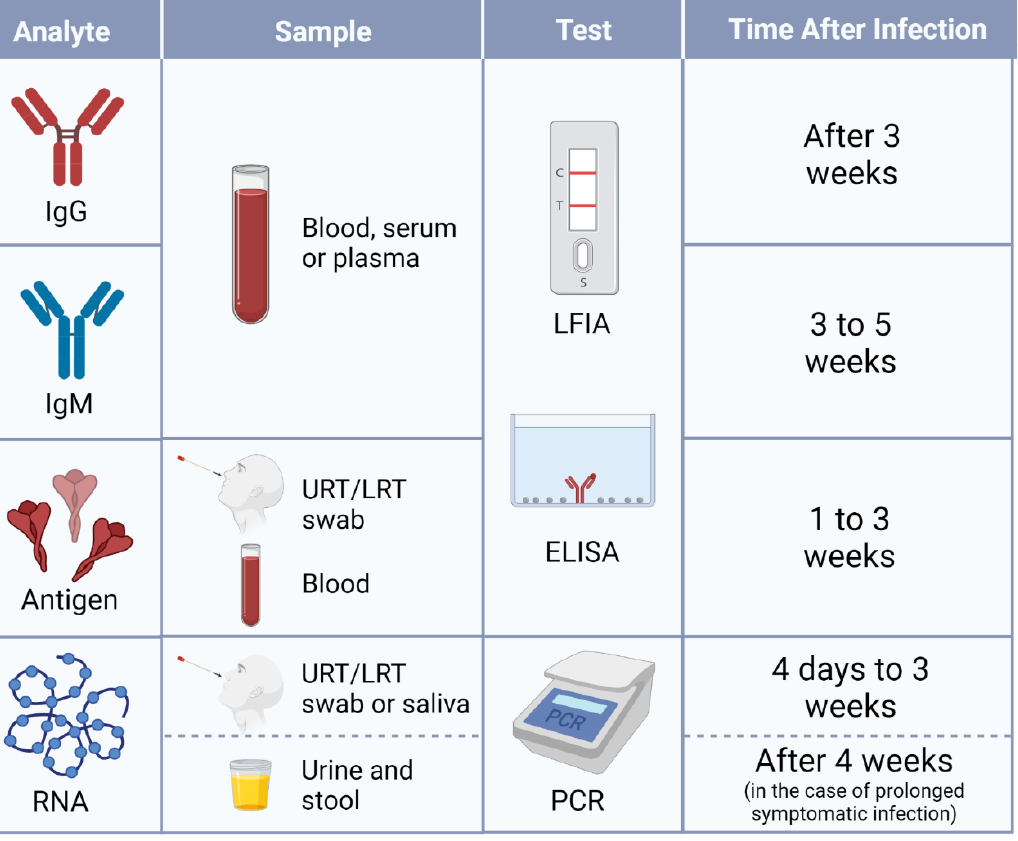
Figure 3. Scheme displaying the most appropriate options regarding type of sample, diagnostic test, and time after infection in order to detect each analyte: RNA, antigens, or antibodies (IgM and IgG).